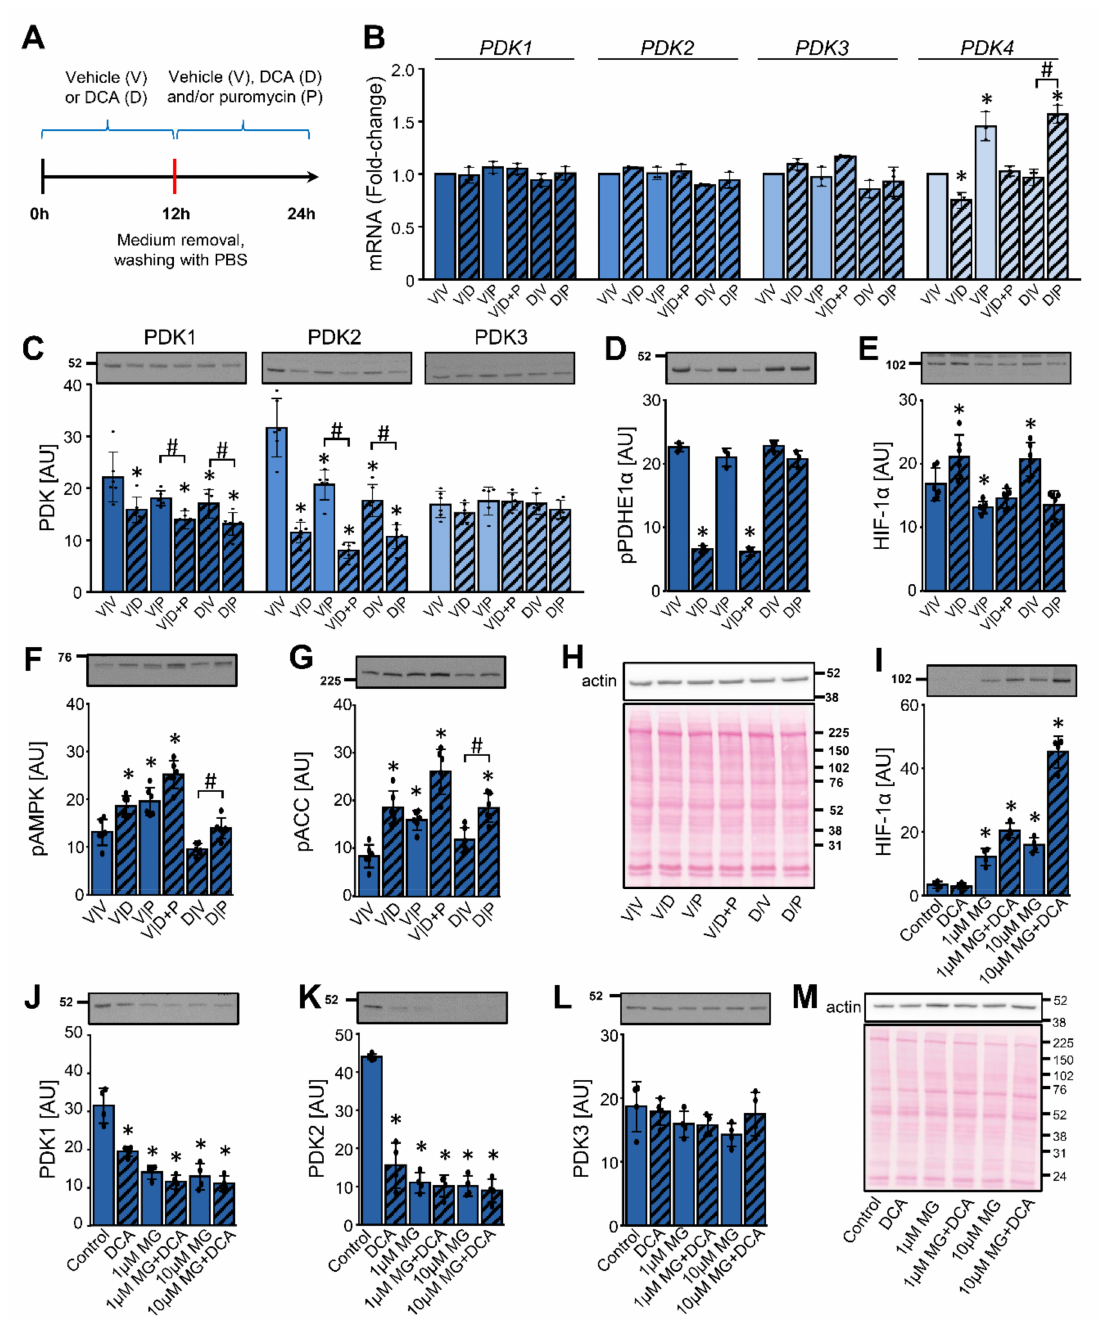
Figure 7. DCA reduces the abundance of PDK1 and PDK2 in L6 myotubes despite upregulation of HIF-1 α and inhibition of the proteasome. ( A – H ) L6 myotubes were treated with 10 mM DCA or vehicle in serum-free minimal essential medium- α (MEM α ). After 12 h of treatment, medium was removed, cells were washed with PBS and fresh MEM α − with vehicle (V), 10 mM DCA (D), and/or 0.5 µ g/mL puromycin (P) was added for the next 12 h. ( B ) The gene expression levels of PDK1, PDK2, PDK3, and PDK4 were analyzed with qPCR (endogenous control: β -actin). Immunoblotting was used to estimate the protein abundance of ( C ) PDK1, PDK2, and PDK3, ( D ) phospho-PDHE1 α Ser293 (pPDHE1 α ), ( E ) HIF-1 α , ( F ) phospho-AMPK Thr172 (pAMPK), and ( G ) phospho-ACC Ser79 (pACC). ( H ) A representative Ponceau S staining of the membrane. Results are means ± SD of two independent experiments, each performed in three replicates ( n = 6). * p < 0.05 vs. V/V and # p ≤ 0.05 as indicated. ( I – M ) The differentiated L6 cells (myotubes) were treated with MG-132 (1 or 10 µ M MG) for 1 h, which was followed by a 24-h treatment with DCA (10 mM) and/or MG-132 (1 or 10 µ M). Immunoblotting was used to estimate the abundance of ( I ) HIF-1 α , ( J ) PDK1, ( K ) PDK2, and ( L ) PDK3. ( M ) Protein loading was evaluated with the Ponceau S staining. Numbers next to the blots and Ponceau stains indicate molecular weight markers in kDa. Results are means ± SD of one experiment in four replicates ( n = 4). * p < 0.05 vs. Control and # p < 0.05 as